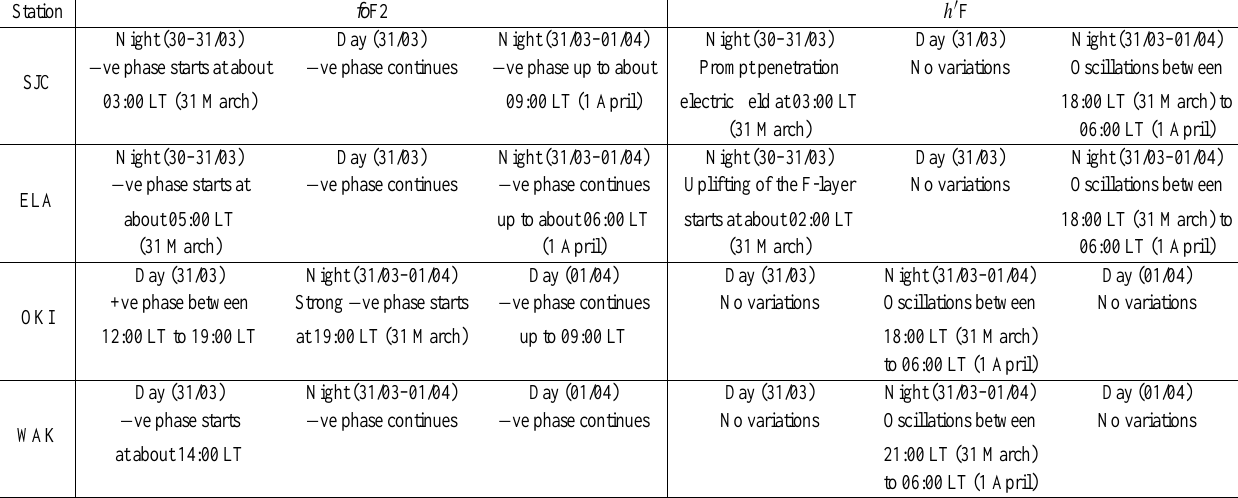
Table 2. Principal characteristics related to the response of the F-region at SJC, ELA, OKI and WAK observed during the major geomagnetic storm with gradual commencement at 01:00 UT and a double-peak main phase at 09:00 UT and 22:00 UT on 31 March